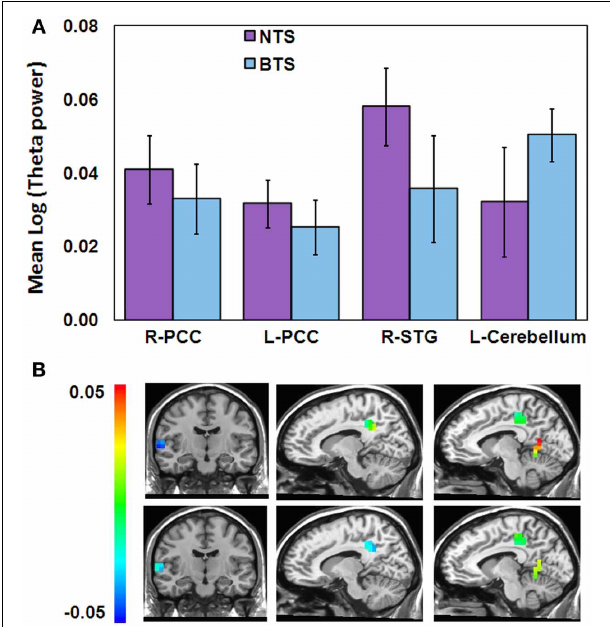
FIGURE 7 | Theta activity differences between the BTS ( n = 4) and NTS ( n = 5) groups over insula. (A) Group main effect. ∗ p < 0 . 05. BTS, both time and space; NTS, Not both Time and Space. (B) Condition × Hemisphere interaction. R, right; L, left. (C) Group differences in theta activity, calculated as BTS minus NTS. Color scale denotes log(theta power) values.